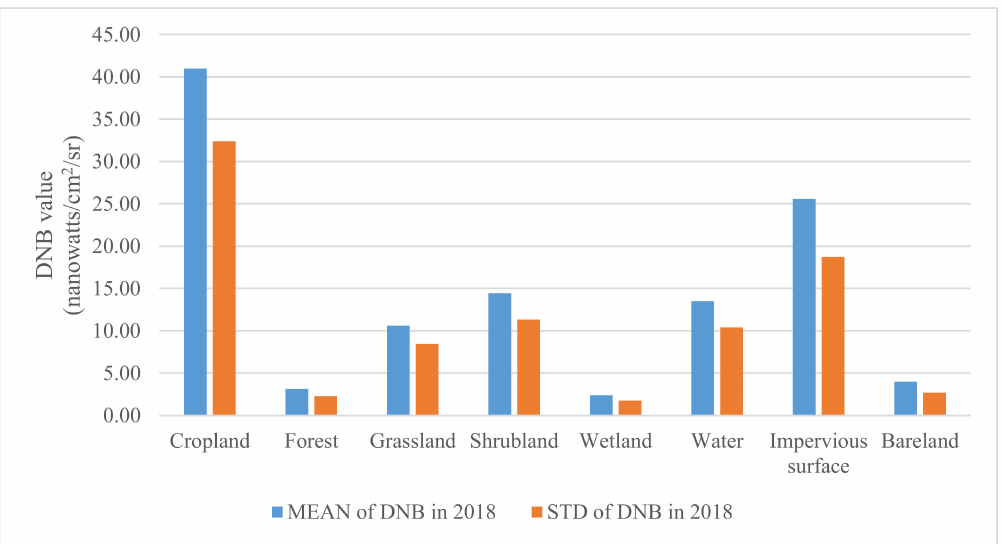
Figure 14. Chart of mean and standard deviation of day / night band (DNB) based on land cover